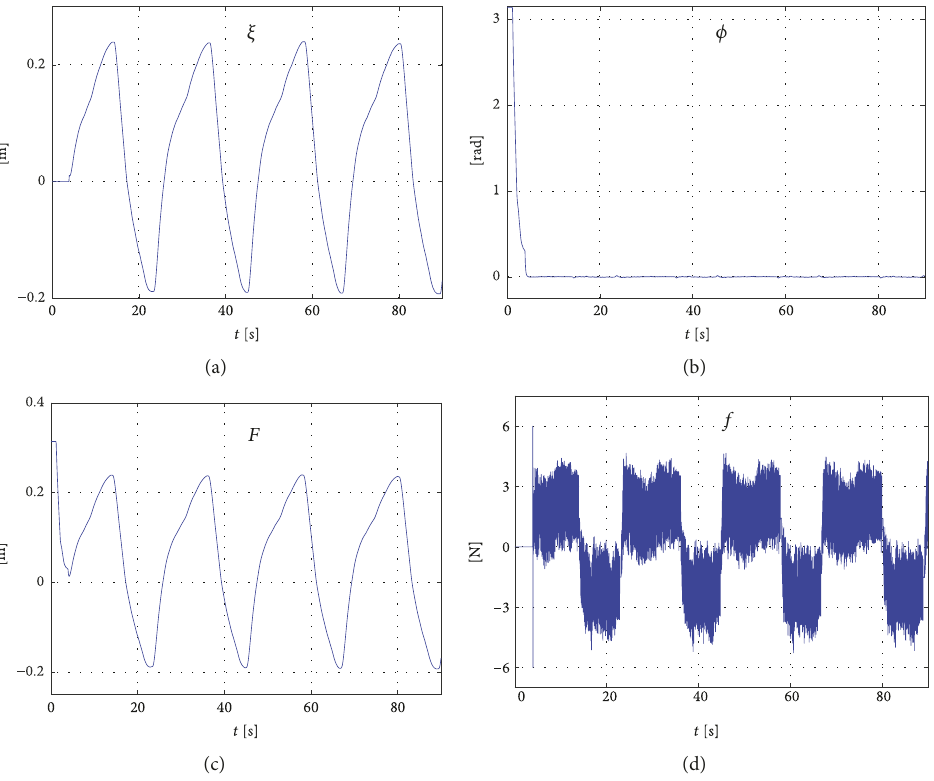
Figure 10: Experimental results when using (36).